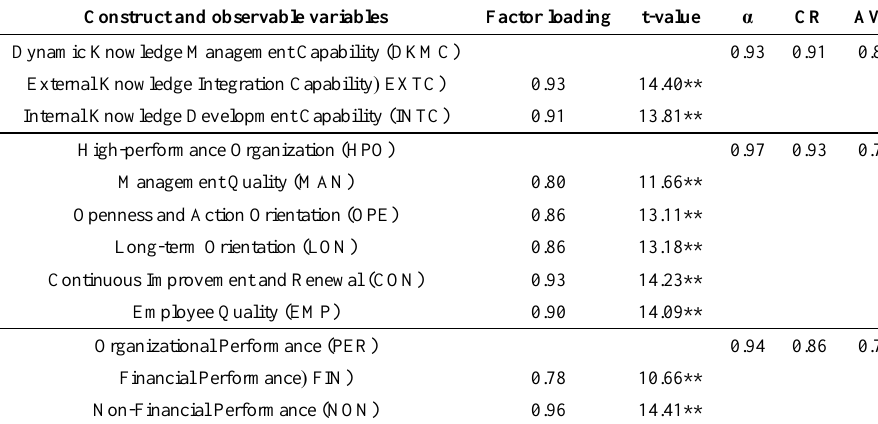
Table 2. Reliability and validity of measurement